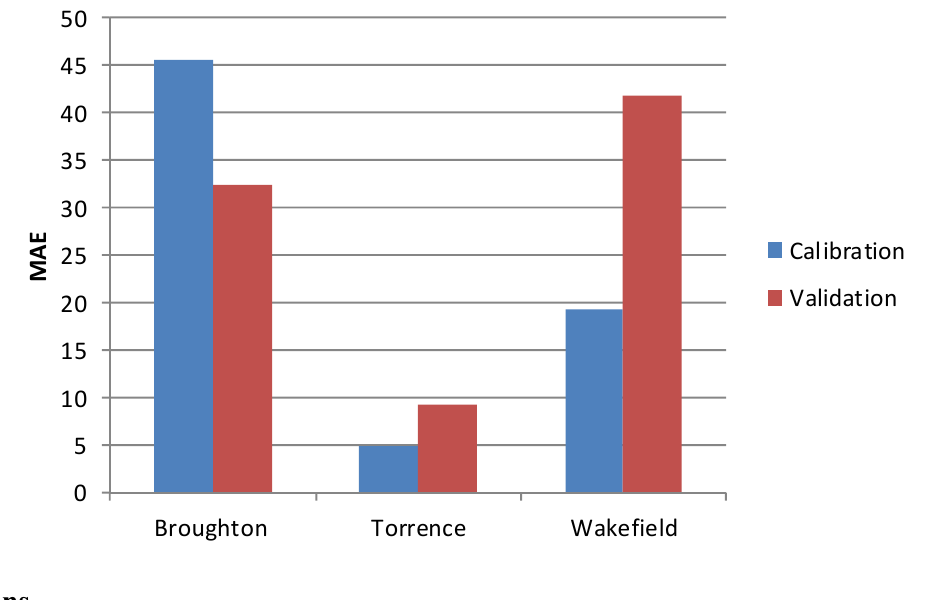
Figure 8. Comparison of MAE for training and testing data, units are in m 3 s − 1